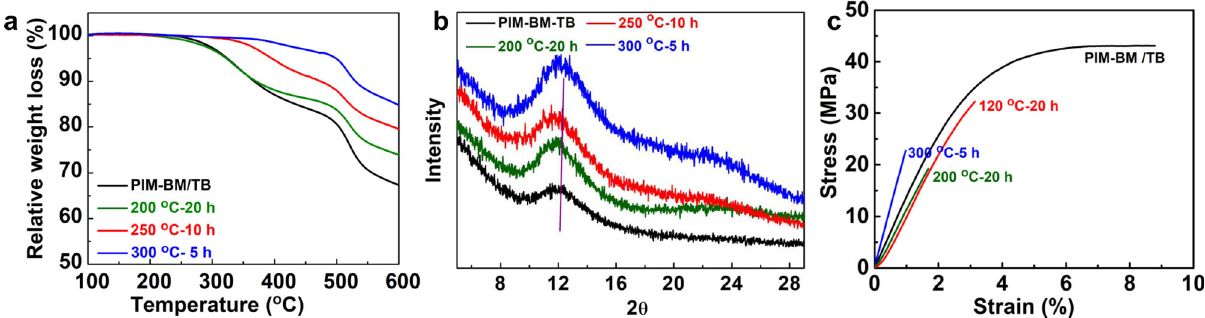
Fig. 4 Properties of crosslinked microporous membranes. a Thermal stability of PIM-BM/TB and crosslinked PIM-BM/TB. b XRD pro fi les. c Mechanical properties of polymer membranes.